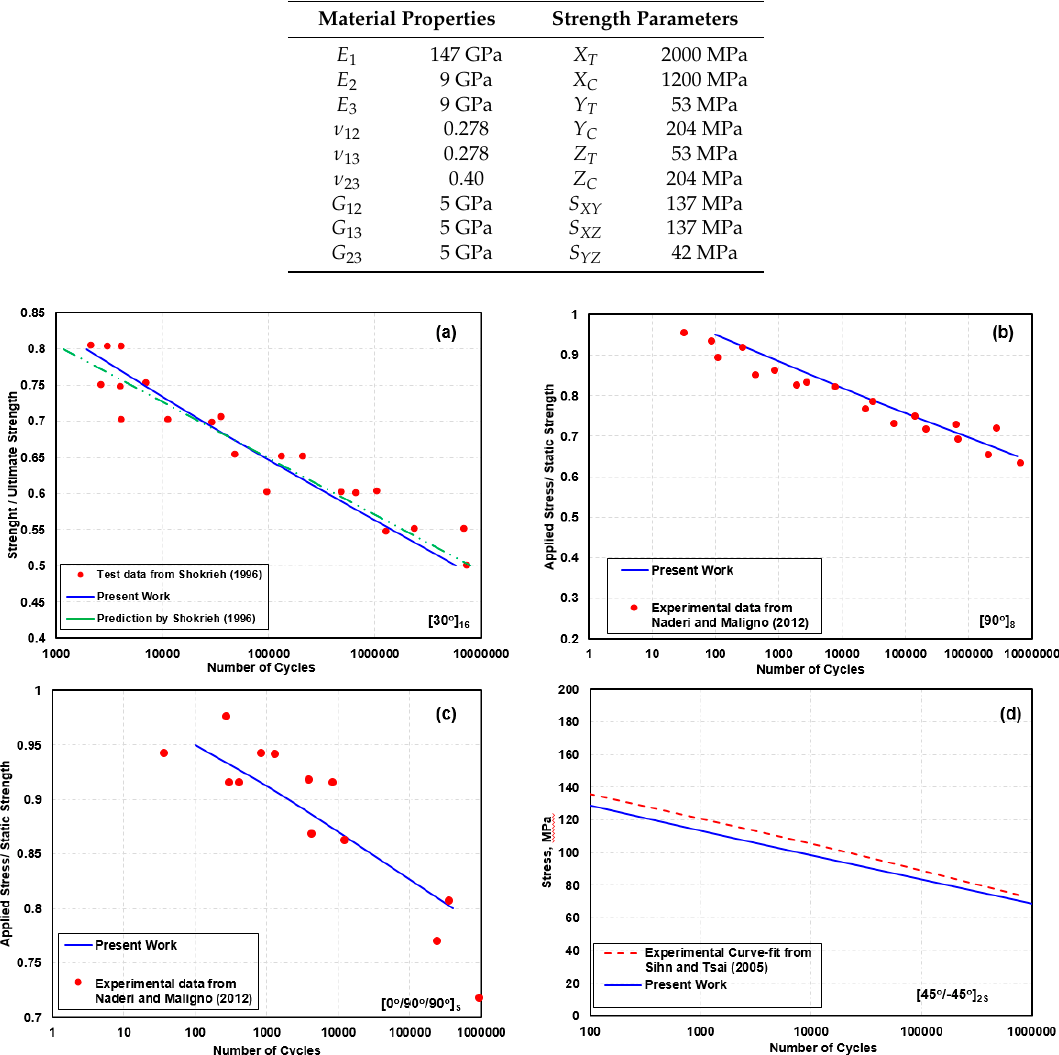
Figure 7. Comparison of fatigue life of present numerical modeling and available experimental data for AS4/3501 laminate subjected to tension–tension fatigue loading at the frequency of 10 Hz and 0.1 load ratio. ( a ) [30°] 16 laminate from Ref. [6]; ( b ) [90°] 8 laminate from Ref. [23]; ( c ) [0°/90°/90°] S from